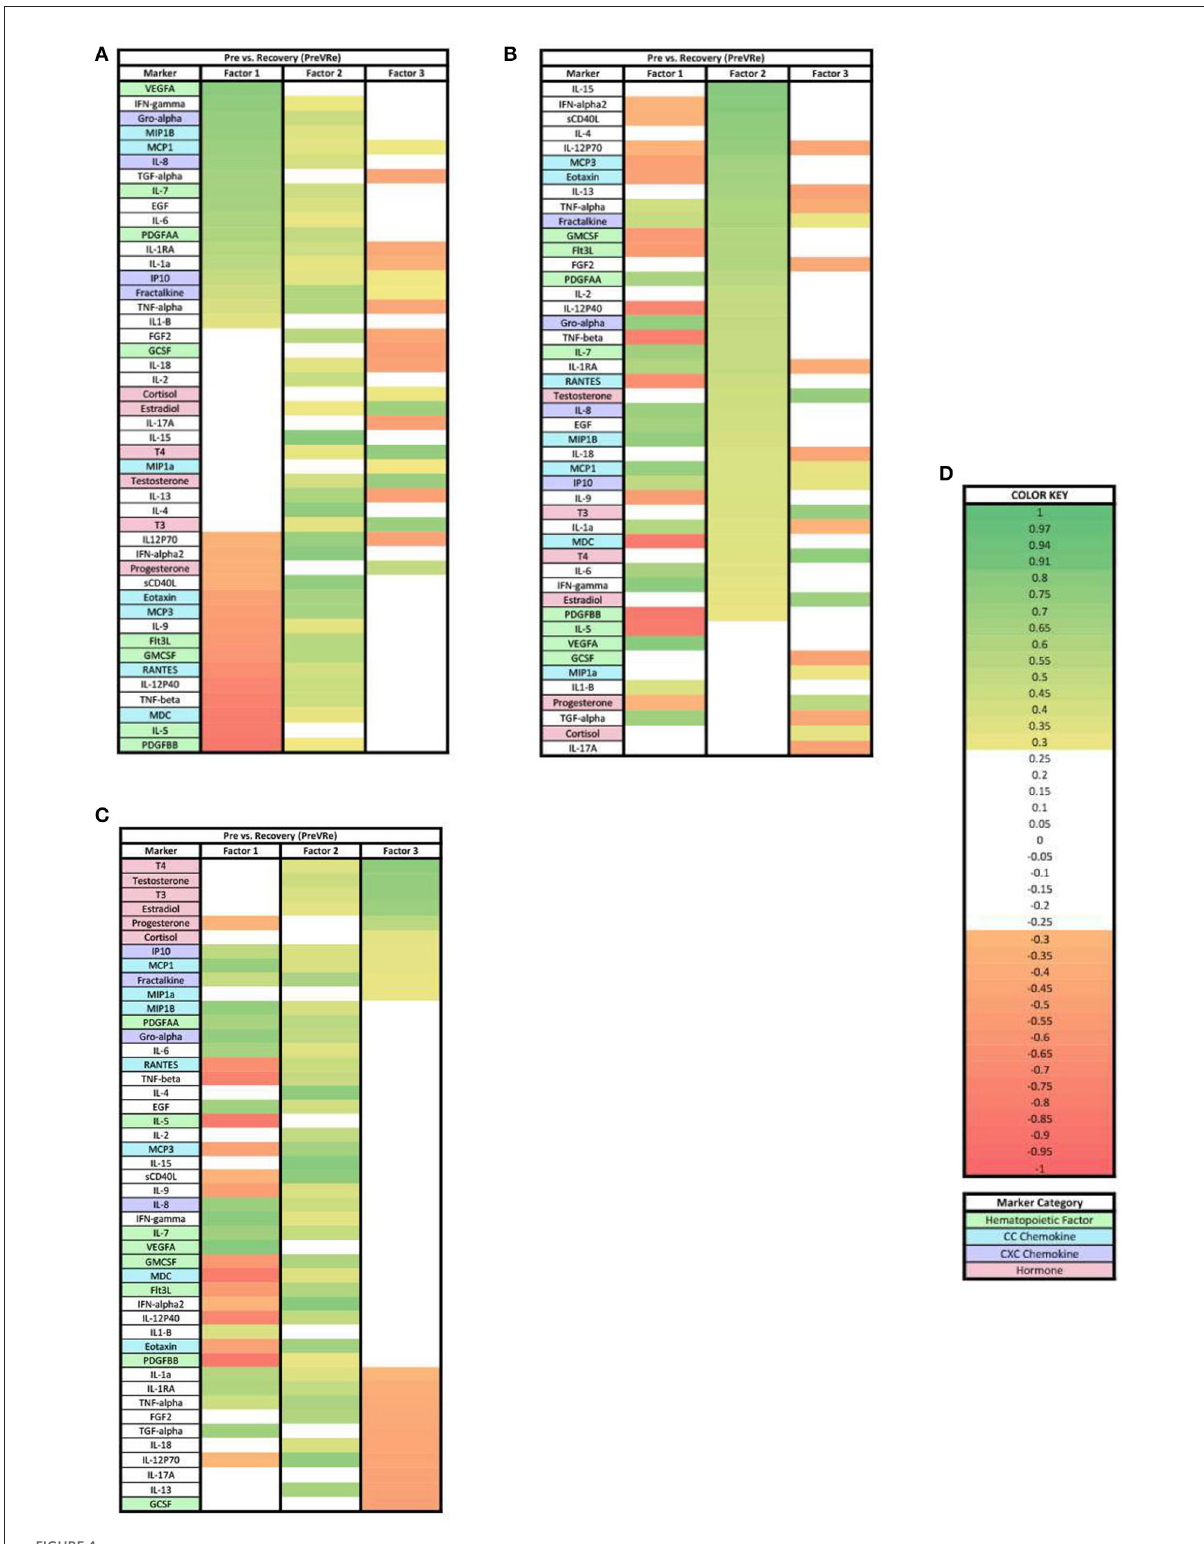
FIGURE4 Heat maps of the post-stress vs. recovery (PreVRe) analysis of loadings ≥ 0.3. (A) Biomarkers sorted from highest to lowest loading in PreVRe factor 1. (B) Biomarkers sorted from highest to lowest loading in PreVRe factor 2. (C) Biomarkers sorted from highest to lowest loading in PreVRe factor 3. (D) Color key for PreVRe loadings ≥ 0.3, sorted top to bottom from most positive to most